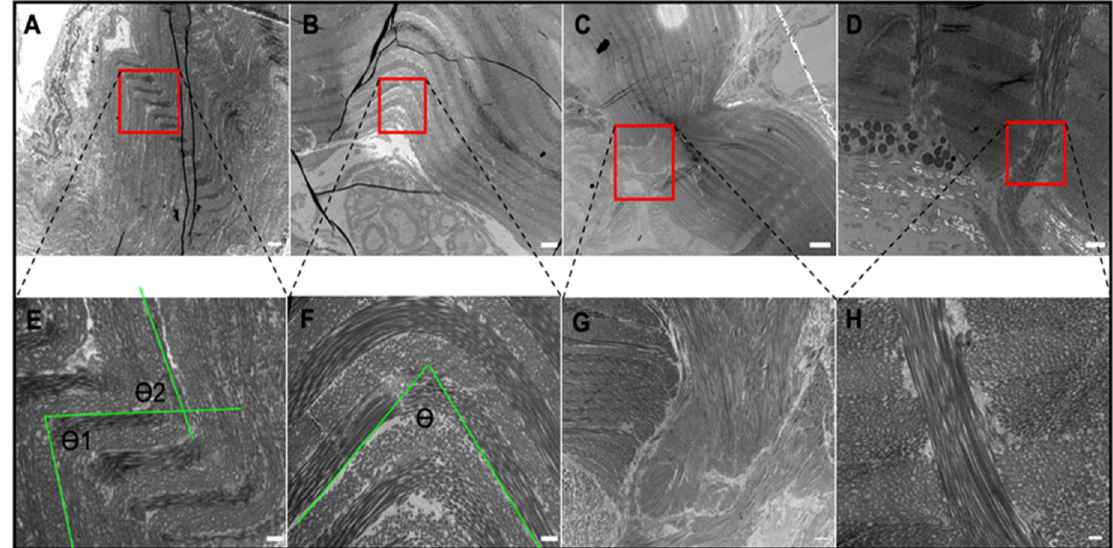
Figure 5. TEM images of gular tissue for ( a ) male EC, 3400×. Scale bar 2 µm; ( b ) female EC, 3400×. Scale bar 2 µm; ( c ) XL, 1000×. Scale bar 10 µm; ( d ) XM, 4200×. Scale bar 10 µm; ( e ) male EC, 13,500×. Scale bar 500 nm. Green lines represent the crimp angle measurements (θ1 = 80°, θ2 = 70°). ( f ) Female EC, 13,500×. Scale bar 500 nm. Green lines represent the crimp angle measurements (θ = 77°). ( g ) XL, 3400×. Scale bar 2 µm. ( h ) XM, 13,500×. Scale bar 500 nm. Red boxes indicate the area magnified.